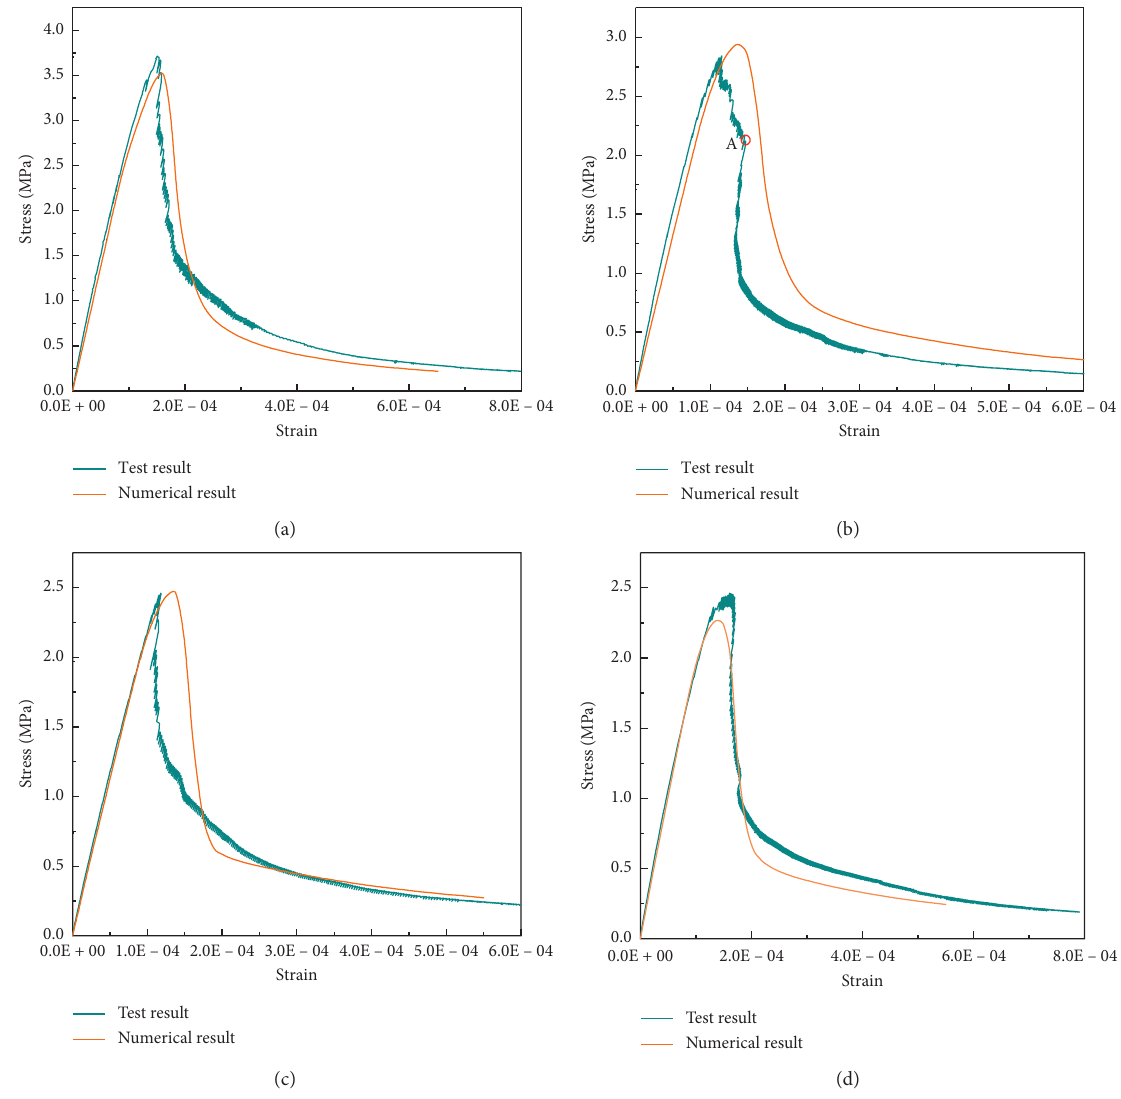
Figure 7: Stress-strain curve of specimen RSCC under uniaxial tension. (a) SCC. (b) RSCC-5%. (c) RSCC-10%. (d)